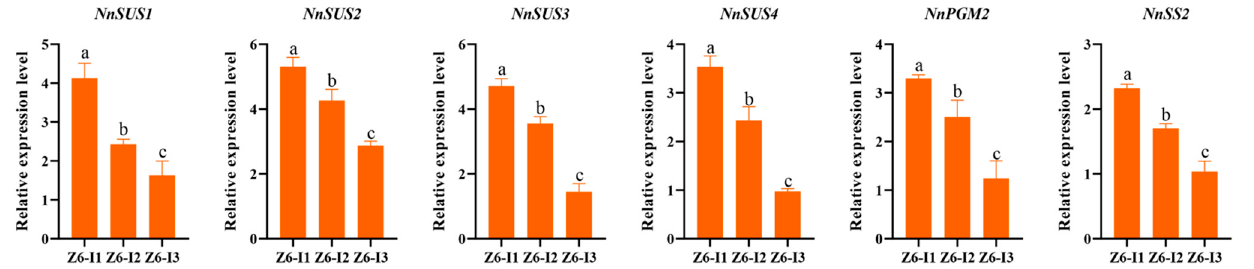
Figure 6. Quantitative RT-PCR validation of selected genes regulated in different internodes. NnTUA was used as the reference gene. All the data were calculated with three biological repeats. Error bars show SD from three biological replicates. The ‘a’, ‘b’ and ‘c’ above the histogram indicated the statistical significance at the level of 0.05 ( p < 0.05).